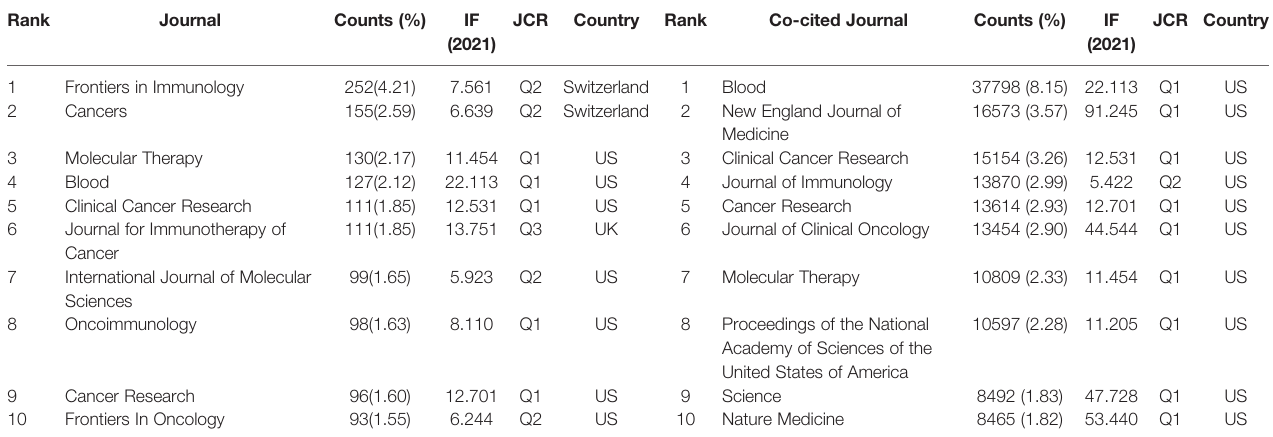
TABLE 1 | Top 10 journals and co-cited journals related to CAR-based